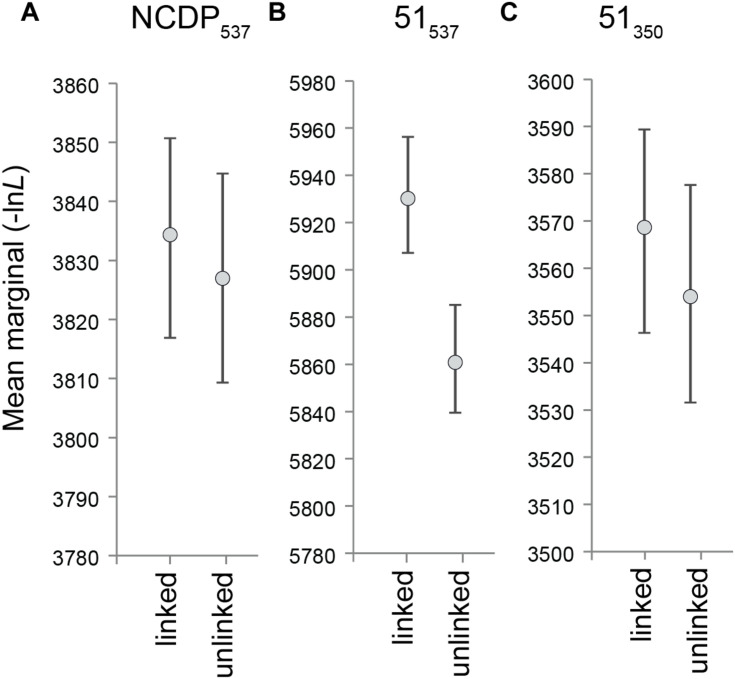
Bayesian inference marginal likelihood means and 95% higher posterior densities (averaged over two runs) for (A) NCDP537, (B) 51537, and (C) 51350, with the tree topology linked and unlinked across the three anatomical regions. lnL advantage = (MLlinked – MLunlinked)/MLunlinked.